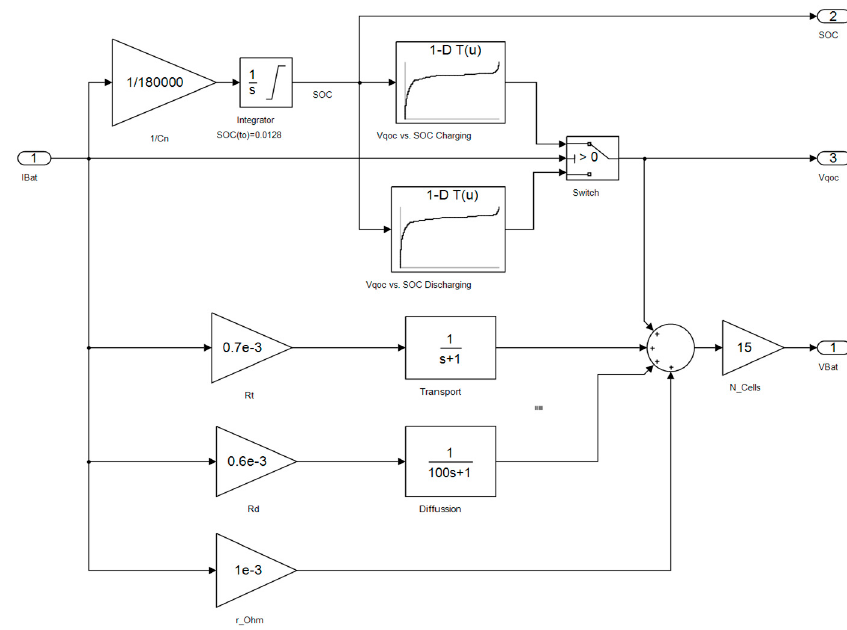
Figure 12. Simulink ® model of the battery.